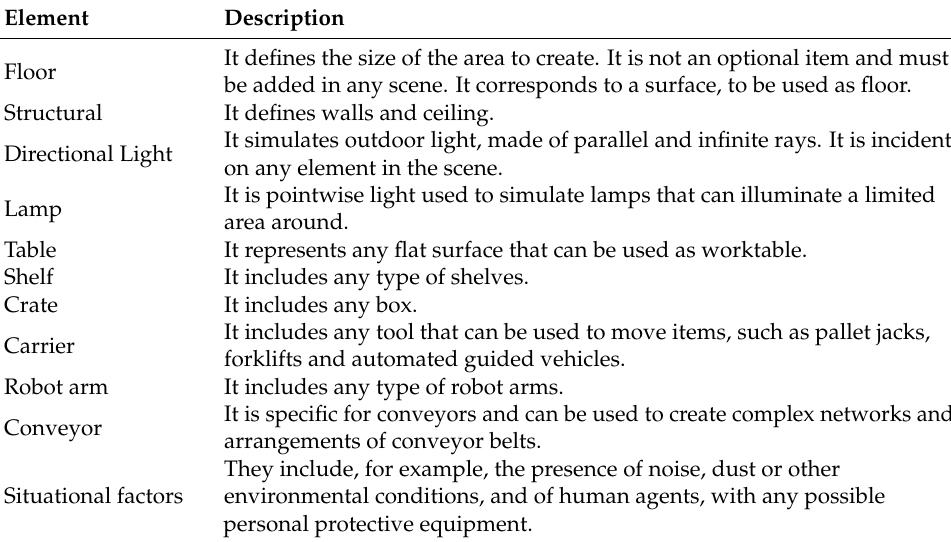
Table 2. Reference list of possible elements to include in the VR